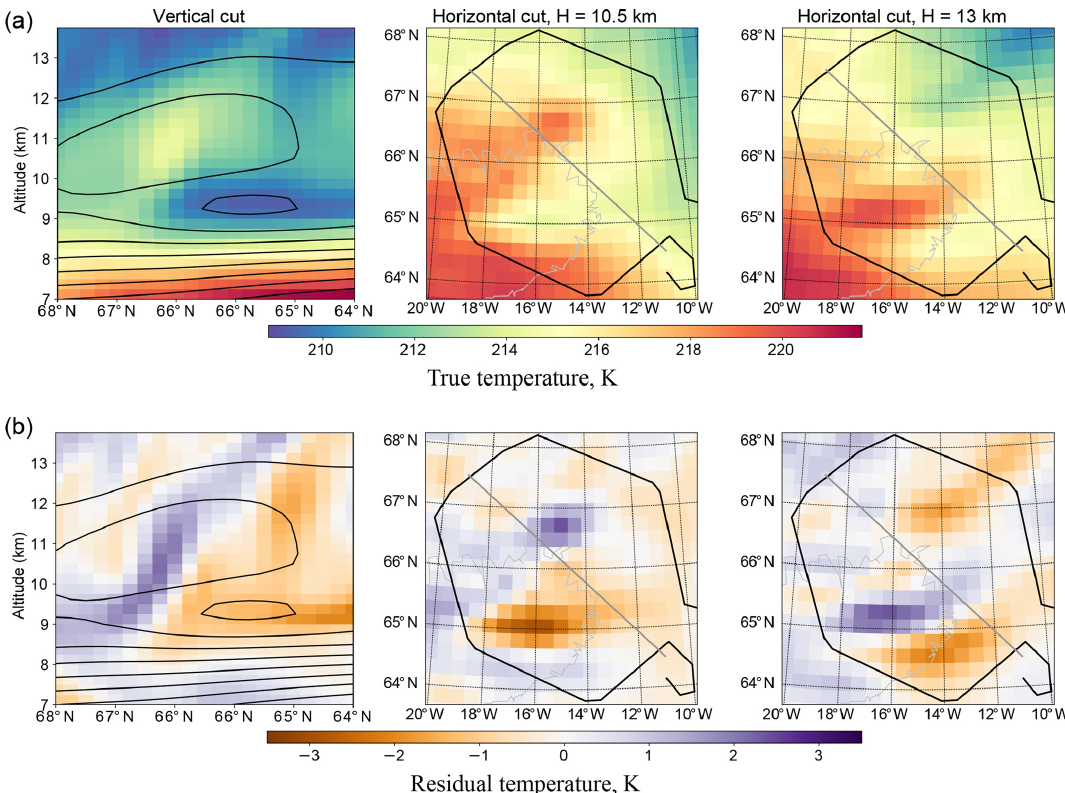
Figure 1. Panel (a) shows the ECMWF temperature data used to generate the synthetic measurements (true temperature). Panel (b) shows the temperature residual: the difference between the true temperature and the smoothed temperature field used as an a priori. In the first column, black lines represent the contours of a priori temperature values. In columns 2 and 3, the black line is the flight path, the thick grey line is the position of the cut shown in the first column and the thin grey line is the topography (Icelandic coastline